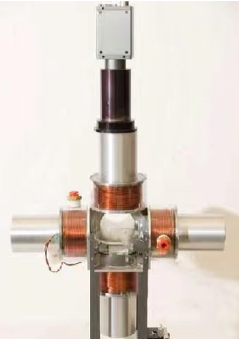
Figure 12. Electromagnetic coil setup consisting of six coils. Two of four horizontal coils are removed to allow viewing of workspace [92].